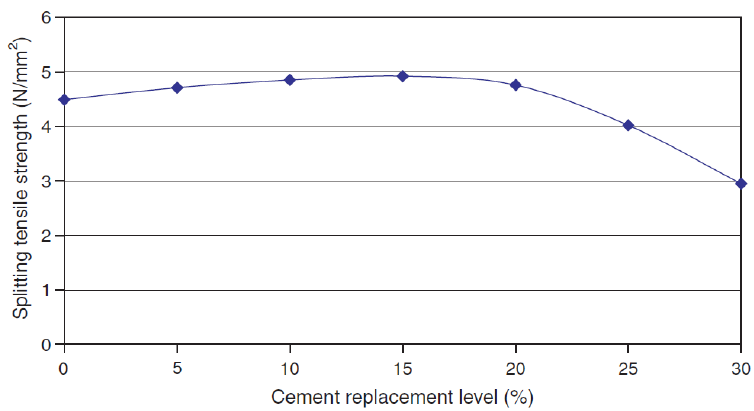
Figure 7. Splitting tensile strength of SCBA blended concretes at 28 days curing [52]